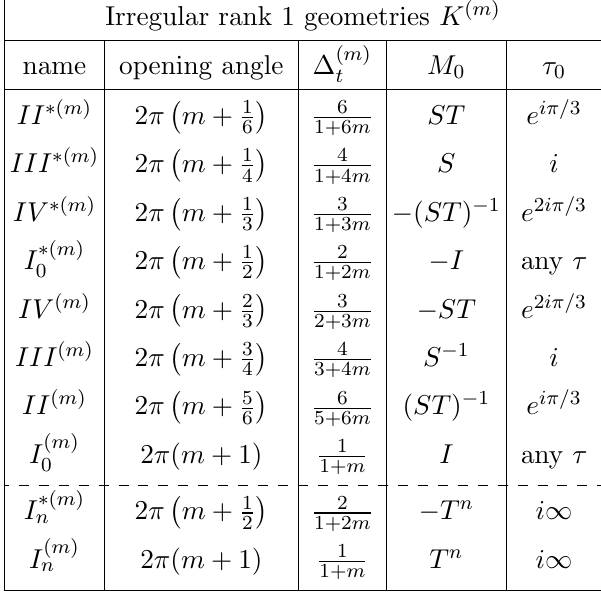
, of the EM duality t